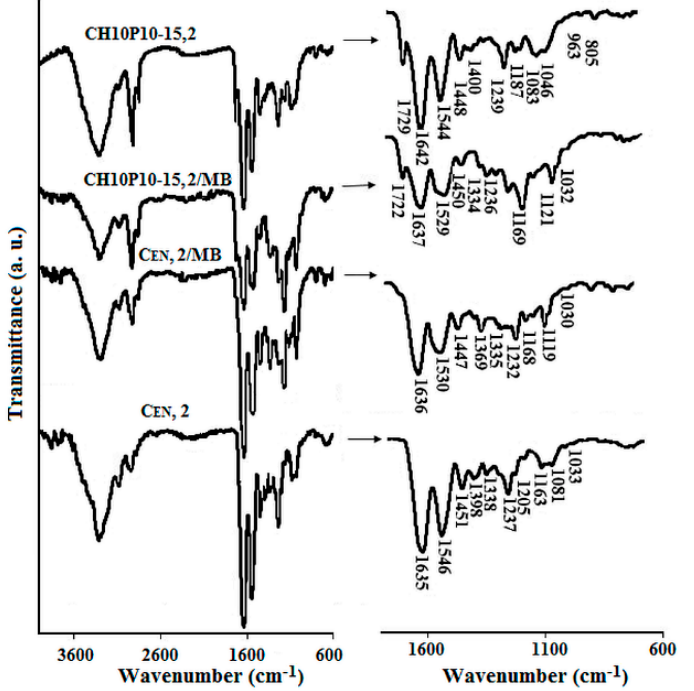
Figure 5. Representative FTIR spectra of the investigated samples before and after MB loading.